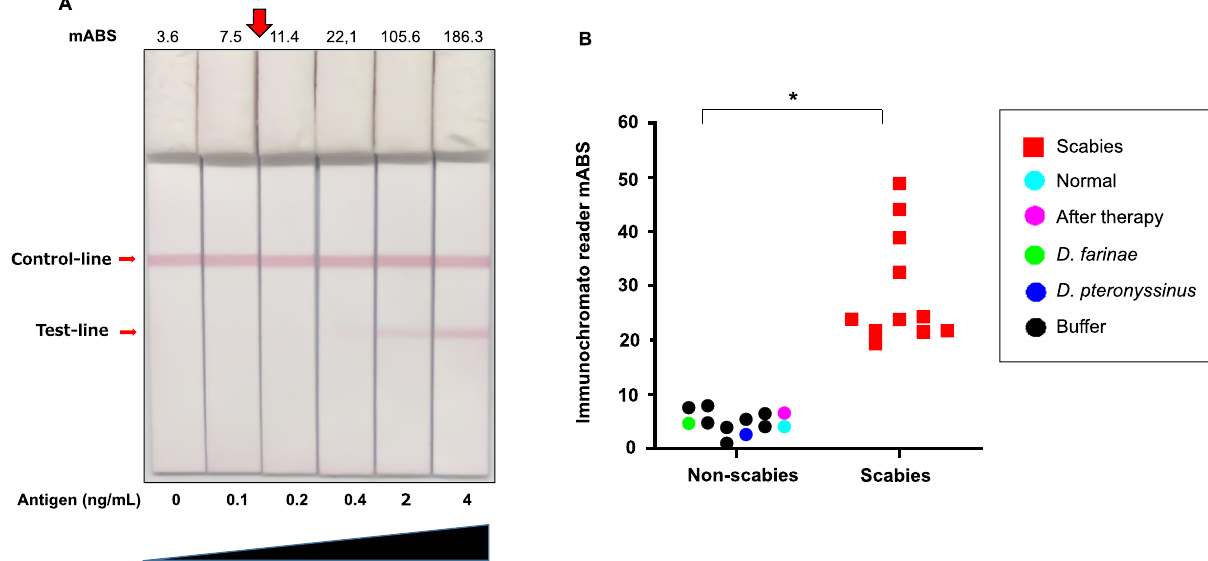
Figure 6. Lateral flow immunoassay for scabies vitellogenin-like protein. ( A ) Sensitivity of immunochromatography test, determined using standard vitellogenin-like protein. A total of 100 μl of serial dilutions (4, 2, 0.4, 0.2, 0.1, and 0 ng/ml) of the synthesized vitellogenin peptide antigen was dispensed onto the cassette and allowed to migrate. Results were read by eye or using an Immunochromato reader after 15 min. Milli Absorbance (mABS) indicated at the top of the lane. The limit of detection (LOD) is indicated using an arrow (0.1–0.2 ng/mL). ( B ) Evaluation of scabies diagnosis using the rapid lateral immunoassay. A total of 100 μL of lysate from skin scrapings of raccoon dogs or whole mite extracts of HDM was dispensed on to the cassette and allowed to migrate. Results determined using the Immunochromato reader are depicted as a dot- plot. It was possible to distinguish between positive (n = 10) and negative (n = 12) readings at a reader value of approximately 10. *; P < 0.05 skin scrapings of raccoon